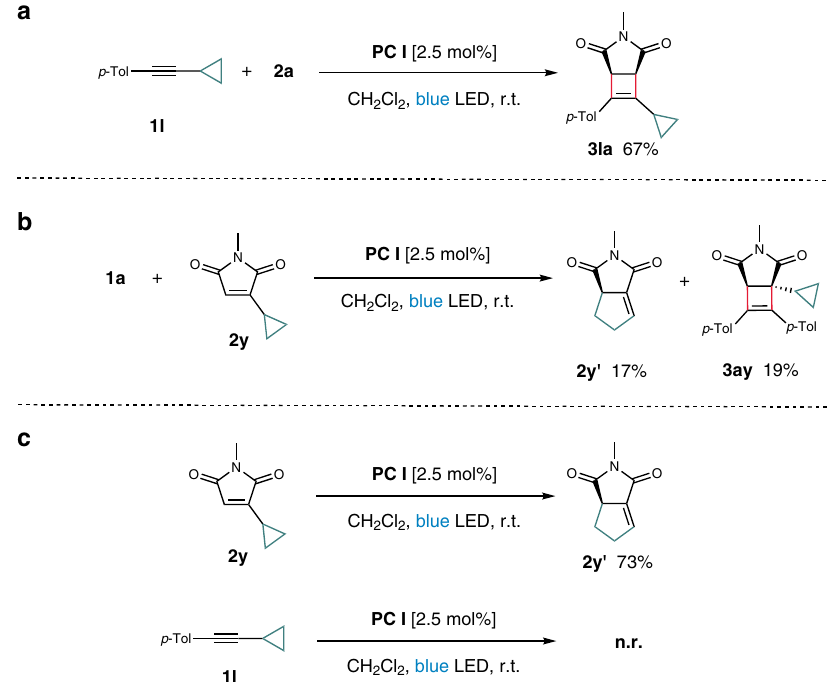
Fig. 6 Radical clock experiments. Racemates for all products. a Intermolecular reaction between cyclopropyl alkyne 1l and 2a . b Intermolecular reaction between 1a and cyclopropyl alkene 2y . c Individual reactivity of 2y and 1l under the standard